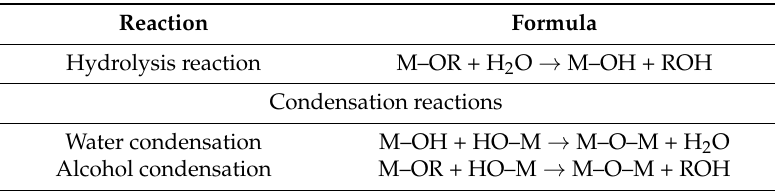
Table 1. Sol Synthesis